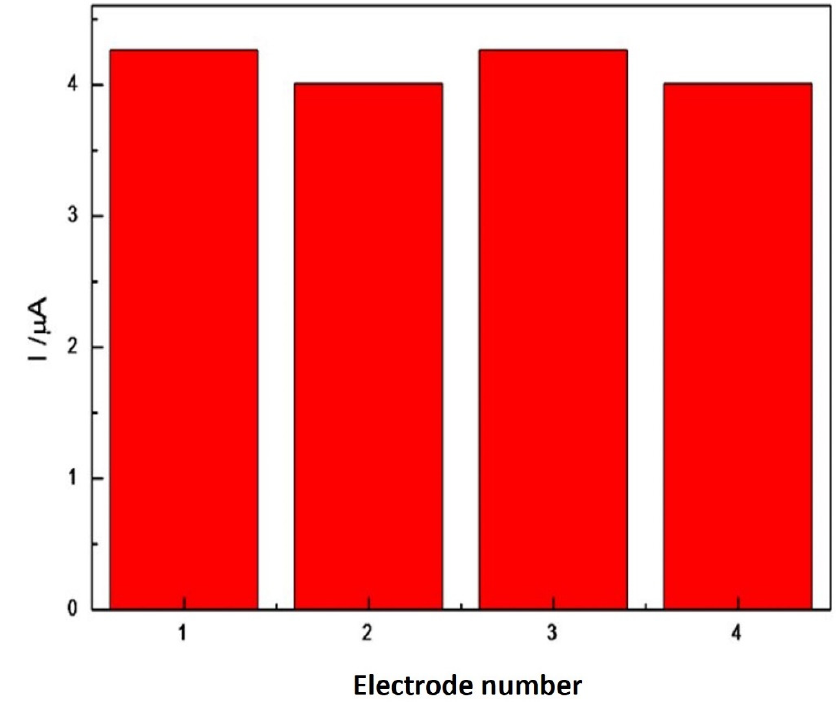
Figure 8. Repeatability study for four electrodes .